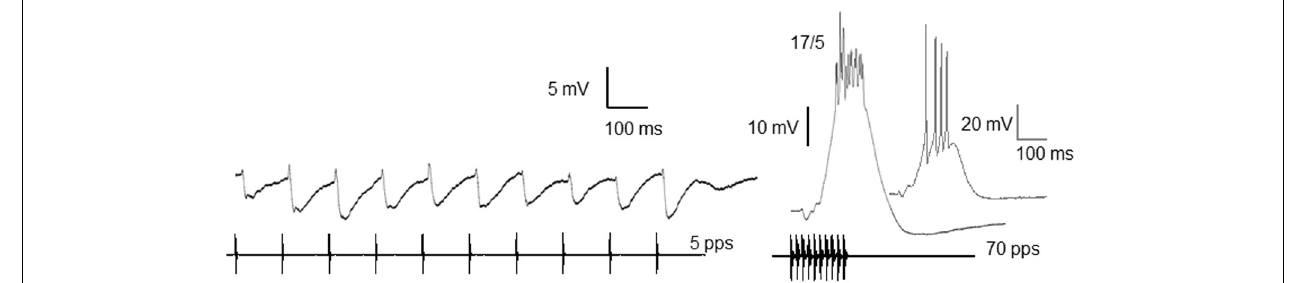
FIGURE 1 | Whole-cell recordings of responses from an interval-counting neuron to stimulus pulses presented at 5 and 70 pulses/s. Averaged traces (black) and a single unaveraged trace (gray, inset) are shown. Ratios: